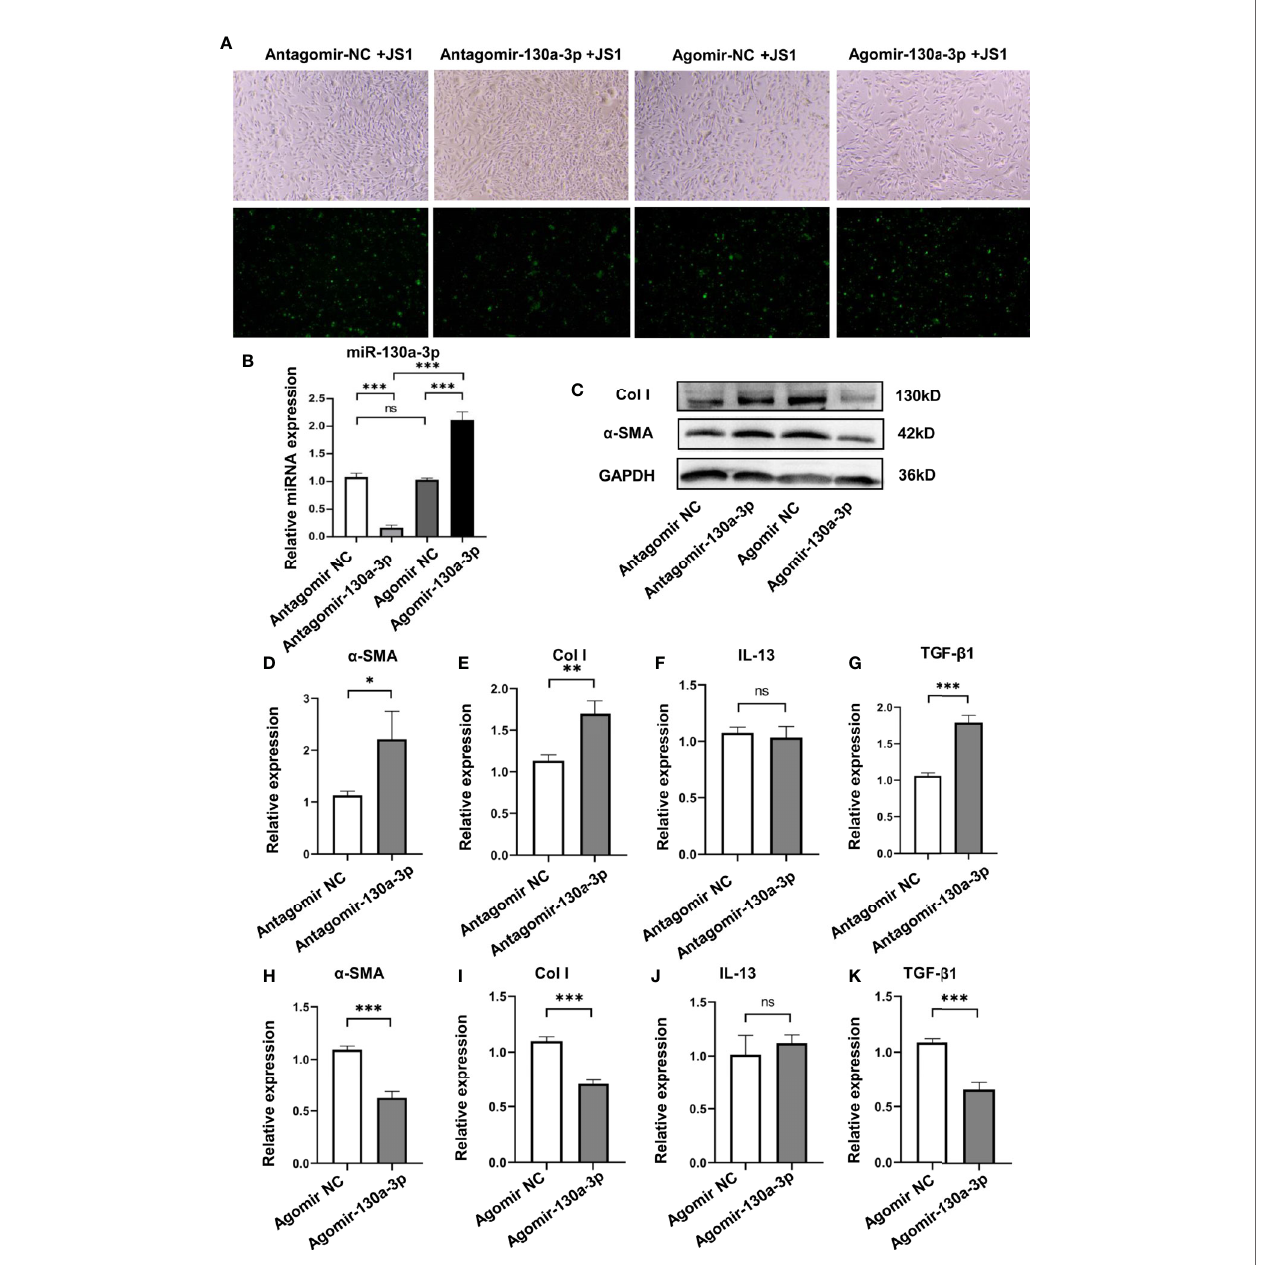
FIGURE 5 | Overexpression of miR130a-3p reduces the activation of JS1 and the expression of fi brogenic factors. JS1 cells were transfected with Agomir-130a-3p/ Agomir NC or Antagomir-130a-3p/Antagomir NC (A) . The transfected JS1 cells were collected after 72 h; the expression of miR-130a-3p was validated by qRT- PCR (B) . The transfected JS1 were collected after 72 h to assay the protein level of a -SMA and Col I by WB (C) , and the mRNA levels of a -SMA, Col I, IL-13, and TGF- b 1 in the gene level were analyzed by qRT-PCR (D – K) . Data represent mean±SD from multigroup experiments. * p < 0.05, ** p <0.01 and *** p <0.001 (n=4 each group). ns, no signi fi